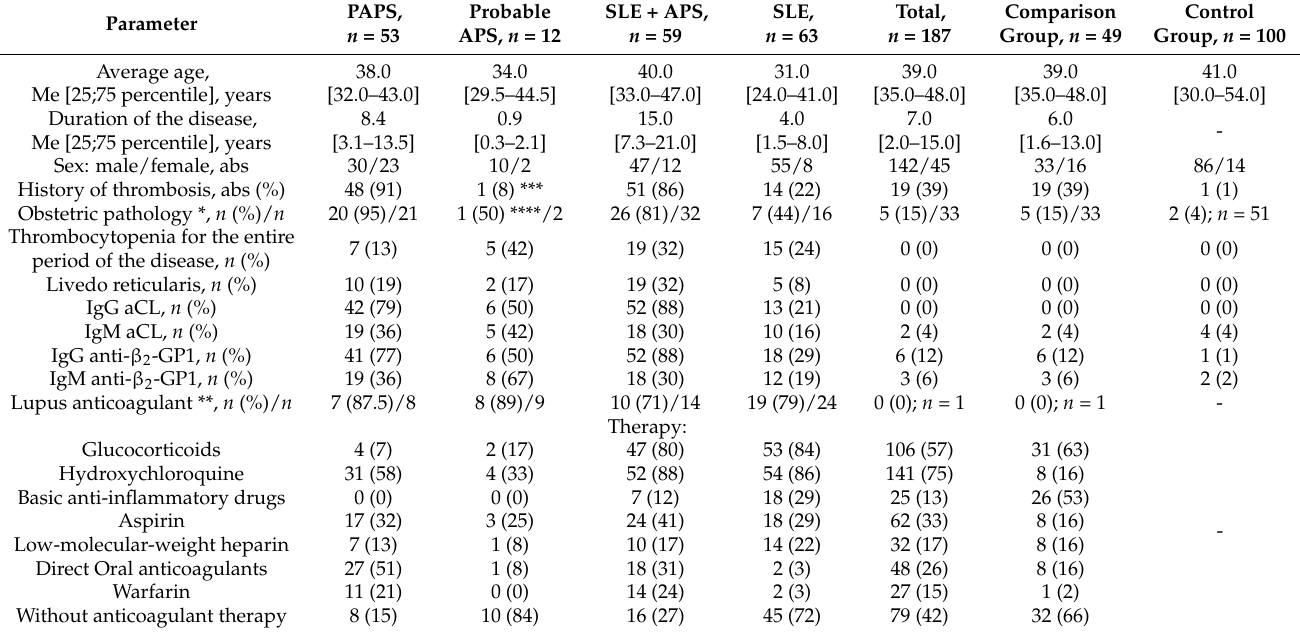
Table 3. The clinical and laboratory characteristics of patients included in the